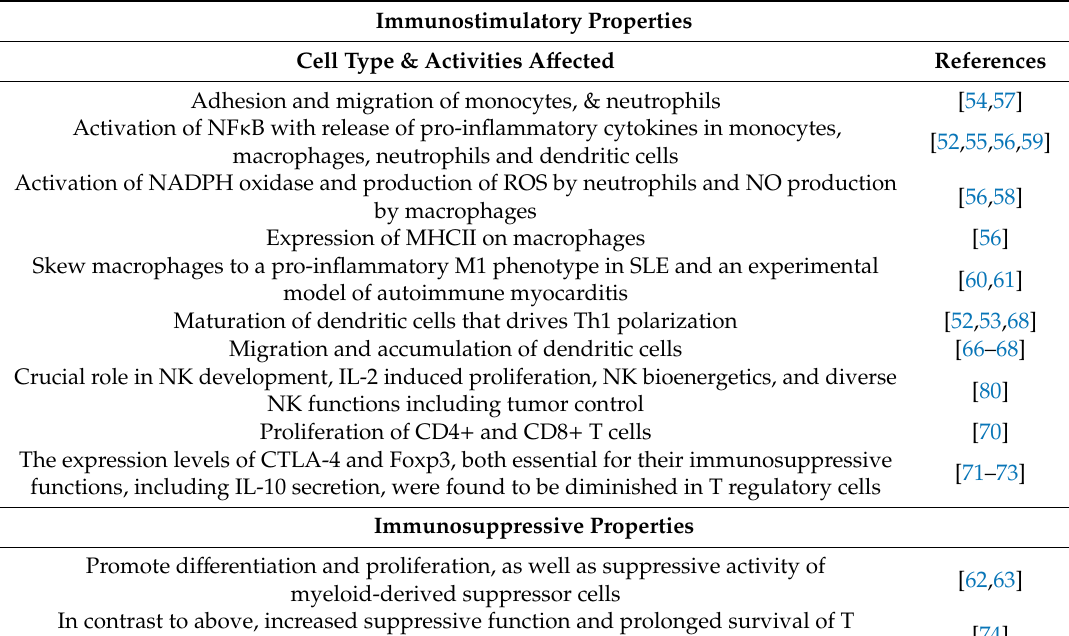
Table 1. Summary of e ff ects of HMGB1 on cells of the immune system in health and